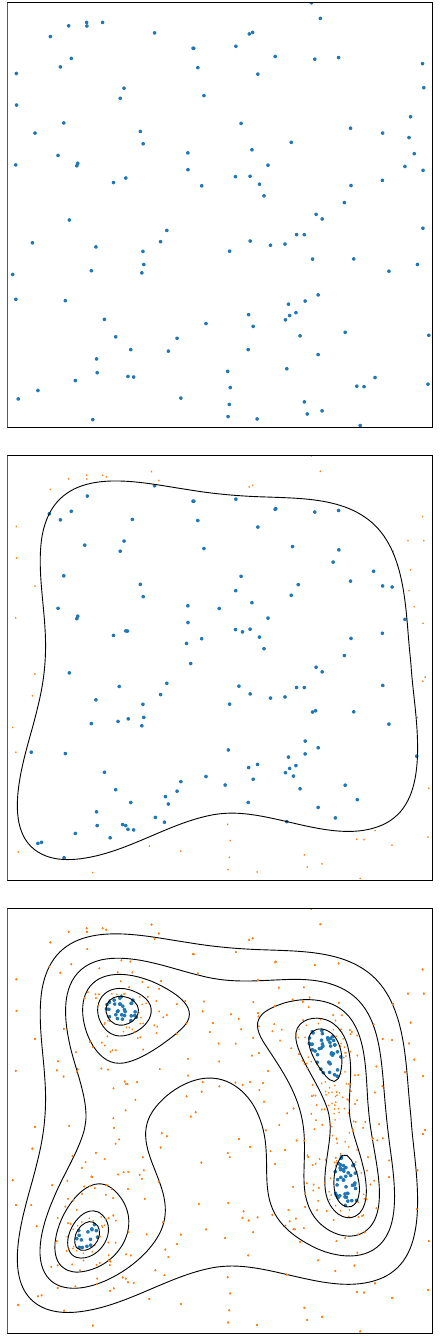
Fig. 1 Schematic of live point evolution (blue dots) in Nested Sam- pling, over a two-dimensional function whose logarithm is the negative Himmelblau function (contours). Points are initially drawn from the unit hypercube (top panel). The points on the lowest contours are suc- cessively deleted, causing the live points to contract around the peak(s) ofthefunction.Aftersufficientcompressionisachieved,thedeadpoints (orange) may be weighted to compute the volume under the surface and samples from probability distributions derived from the .